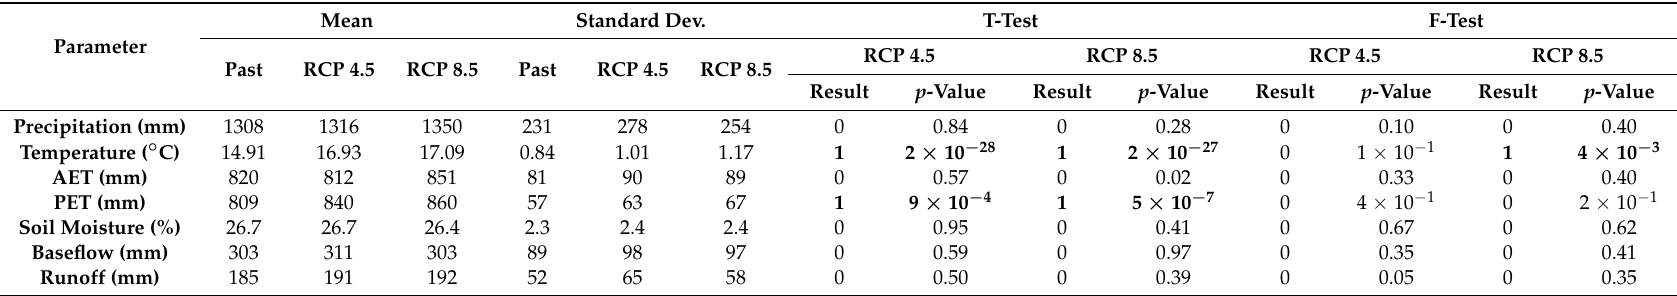
Table 4. Statistical comparison of average annual fluxes for two 20-year periods of 1996–2005 (historical) and 2031–2050 (projected; RCP 4.5 and RCP 8.5). Results of 0 and 1 show, respectively, statistically insignificant and significant changes (significance level 0.01). The statistically significant changes are highlighted in